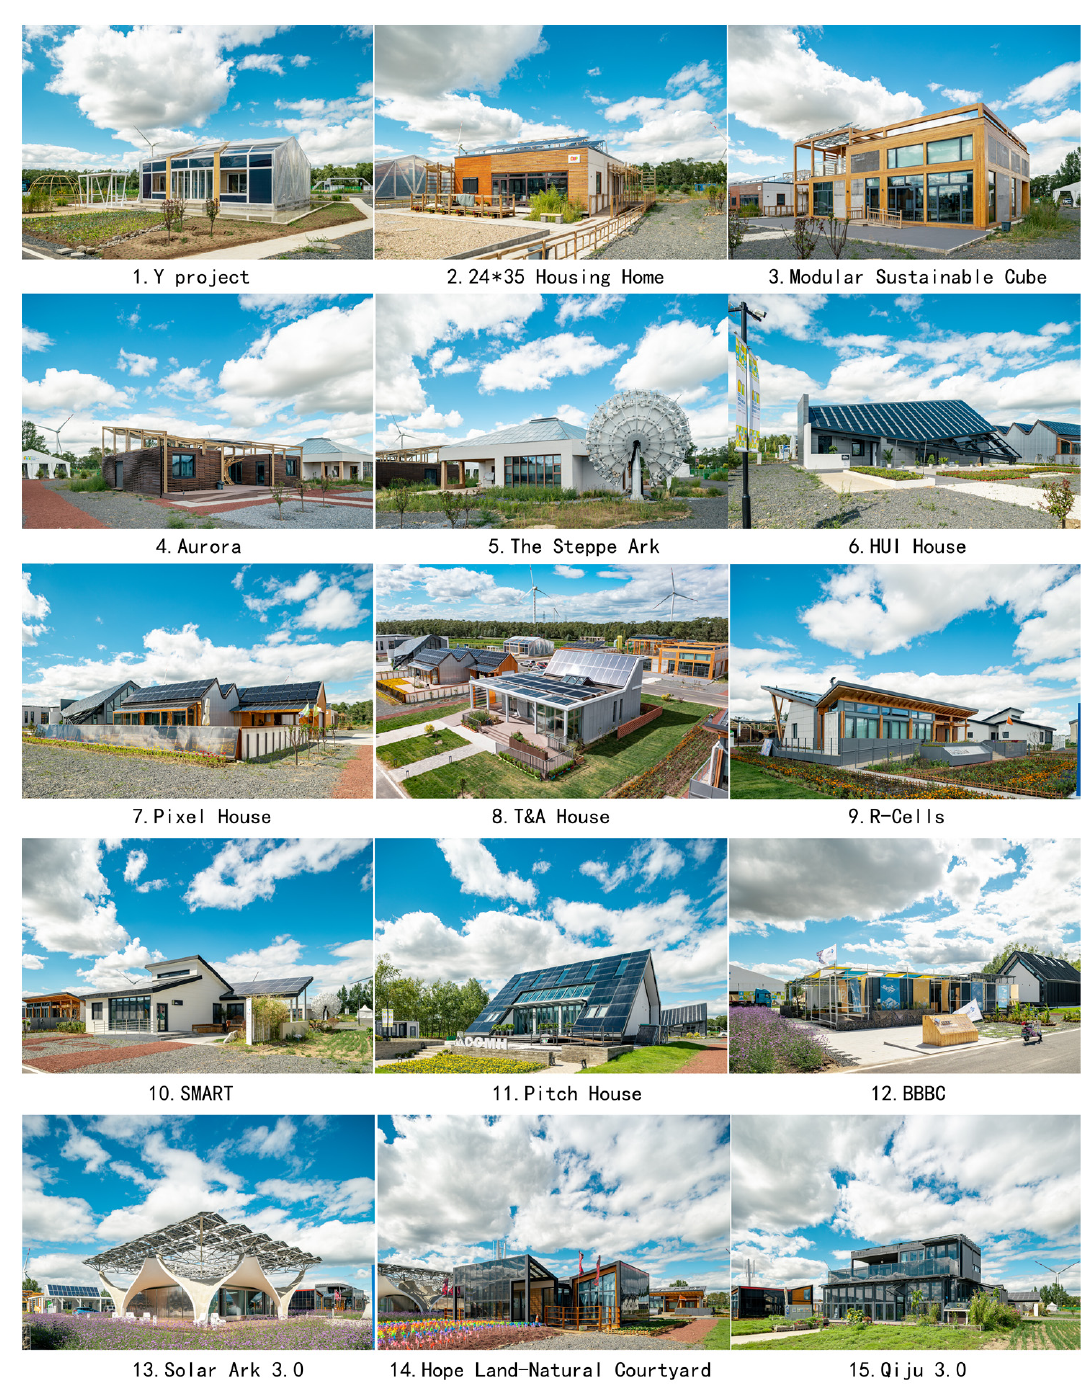
Figure 1. Entries of the third Solar Decathlon China. Table 1. Entries and team information of the third Solar Decathlon China.